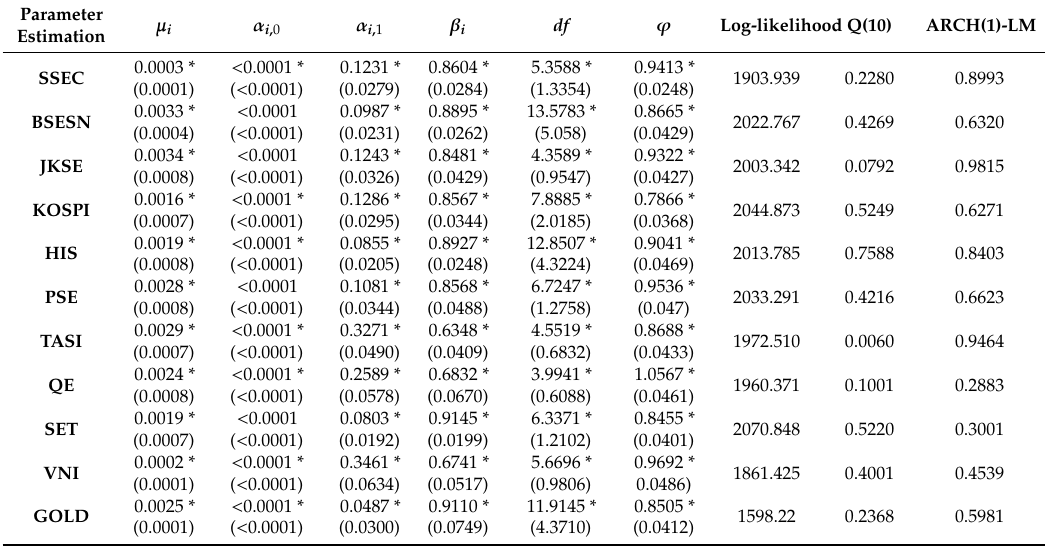
Table 3. Estimates by GARCH (1,1)-skew-t model for the returns of ten stocks and gold. Parameter Estimation